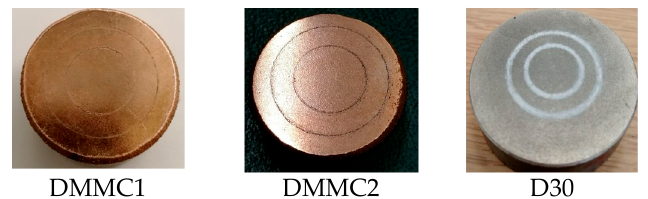
Figure 9. Wear scars on disks after test.